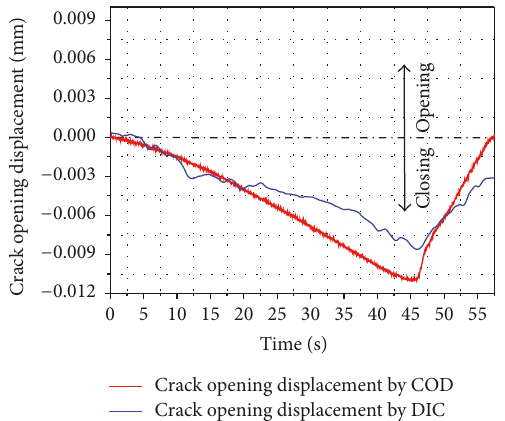
Figure 12: Crack opening displacement for the disc with a 25 mm long preexisting crack oriented at 54 ∘ measured by COD device and DIC method.